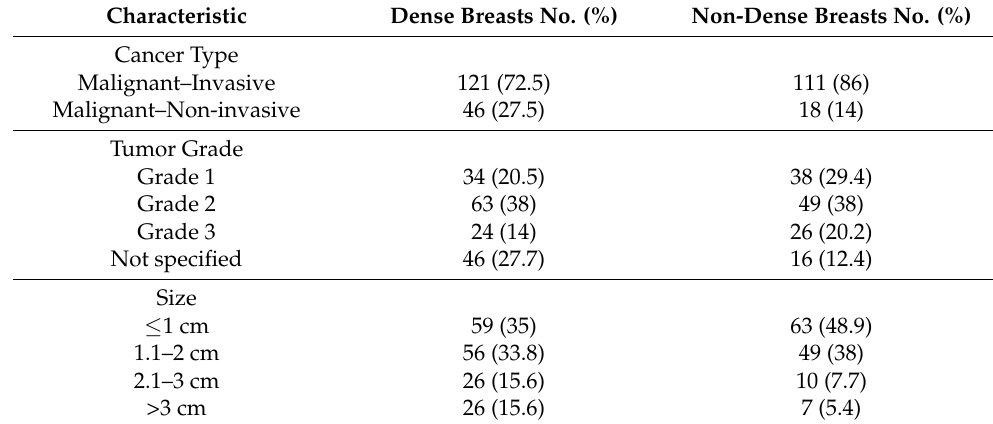
Table 2. Breast cancer characteristics across dense and non-dense breasts. Characteristic